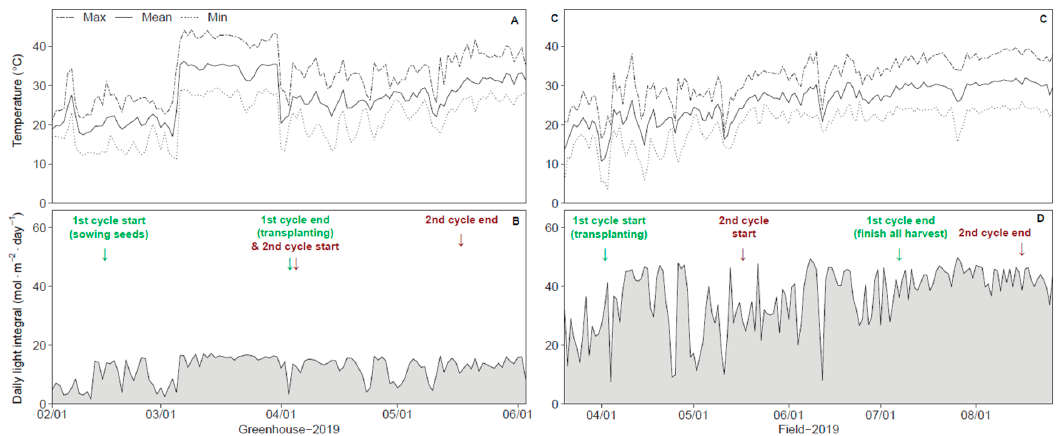
Figure 1. Temperature, daily light integral, and growing cycles (cool and hot seasons indicated by arrows) of greenhouse ( A , B ) and field ( C , D ) from 1 February, 2019 to 30 August, 2019.